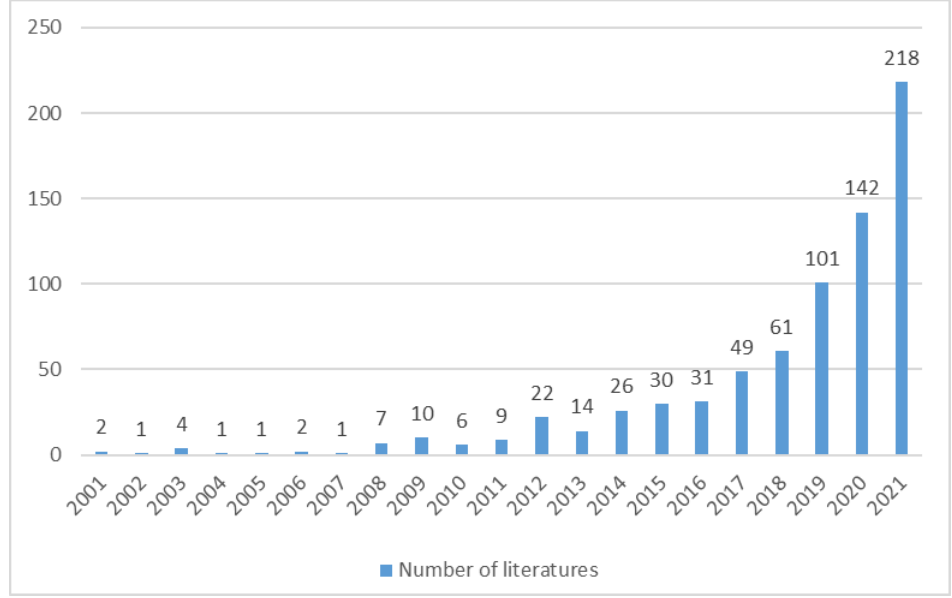
Figure 1. The number of published papers from 2001 to 2021.